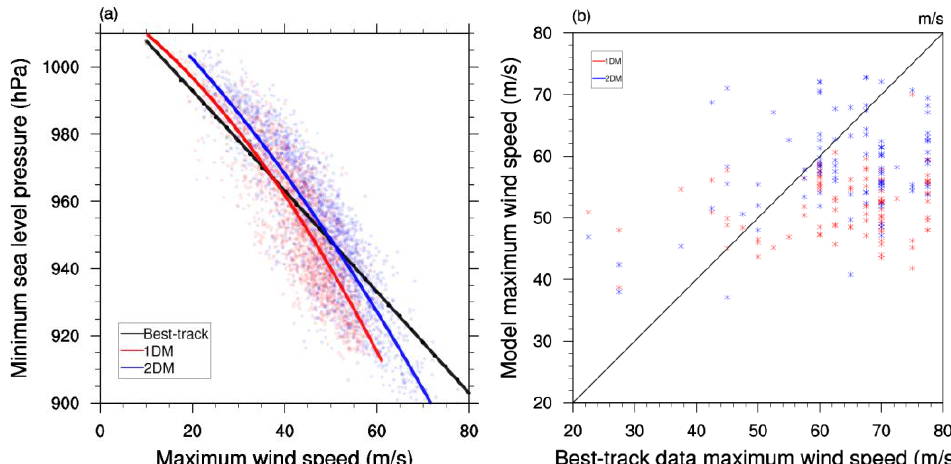
Figure 3. ( a ) Wind-pressure relationship of 1DM (red) and 2DM (blue) experiments with JTWC best track data (black). The solid lines show the second-order polynomial fit for each data set. ( b ) Scatter plot of LMI simulated by 1DM (red) and 2DM (blue) experiments as a function of LMI from the best-track data.